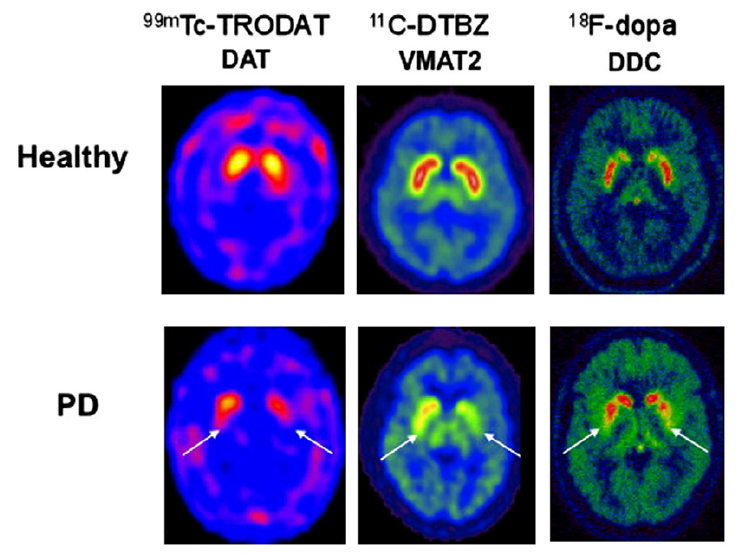
Figure 2. Imaging dopamine terminal function in healthy controls and early Parkinson’s disease (Modified from